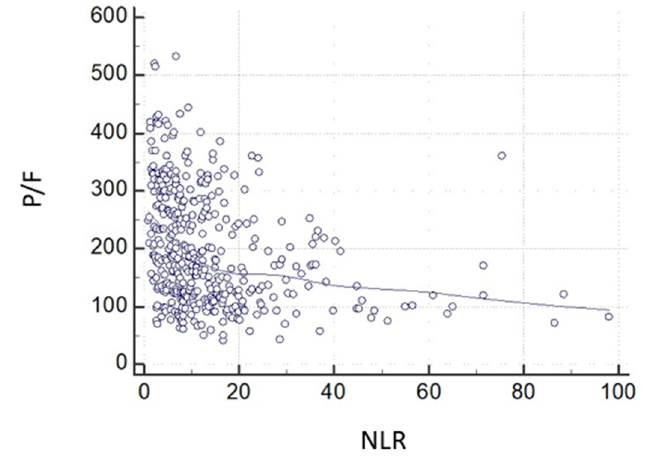
Figure 5. Relationship between the neutrophil-to-lymphocyte ratio and the P/F ratio at baseline (r = 0.39; p < 0.0001).